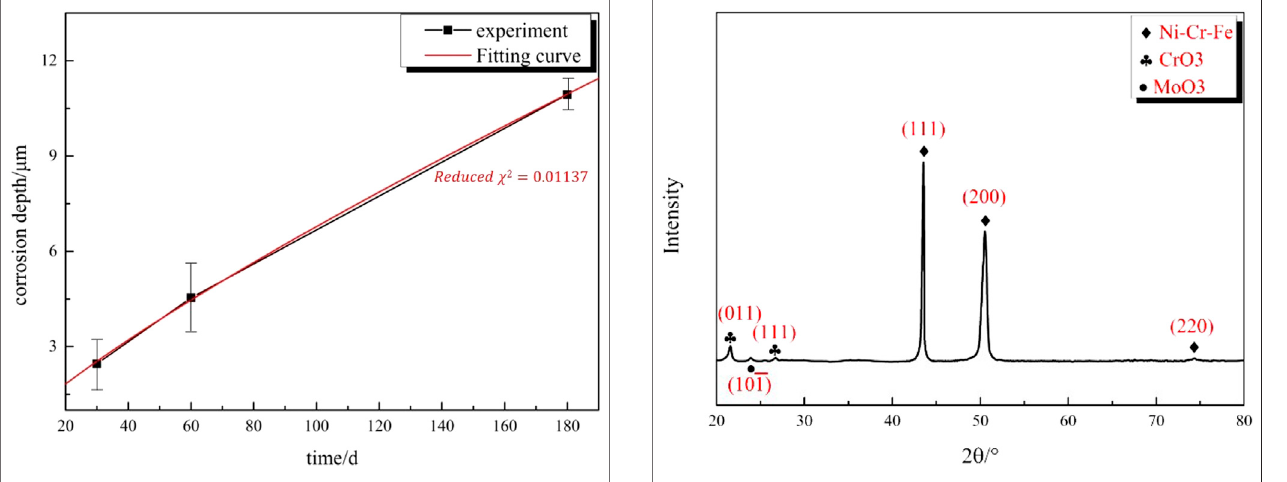
FIGURE 9 | Experimental and fi tting relationship between corrosion depth and time.